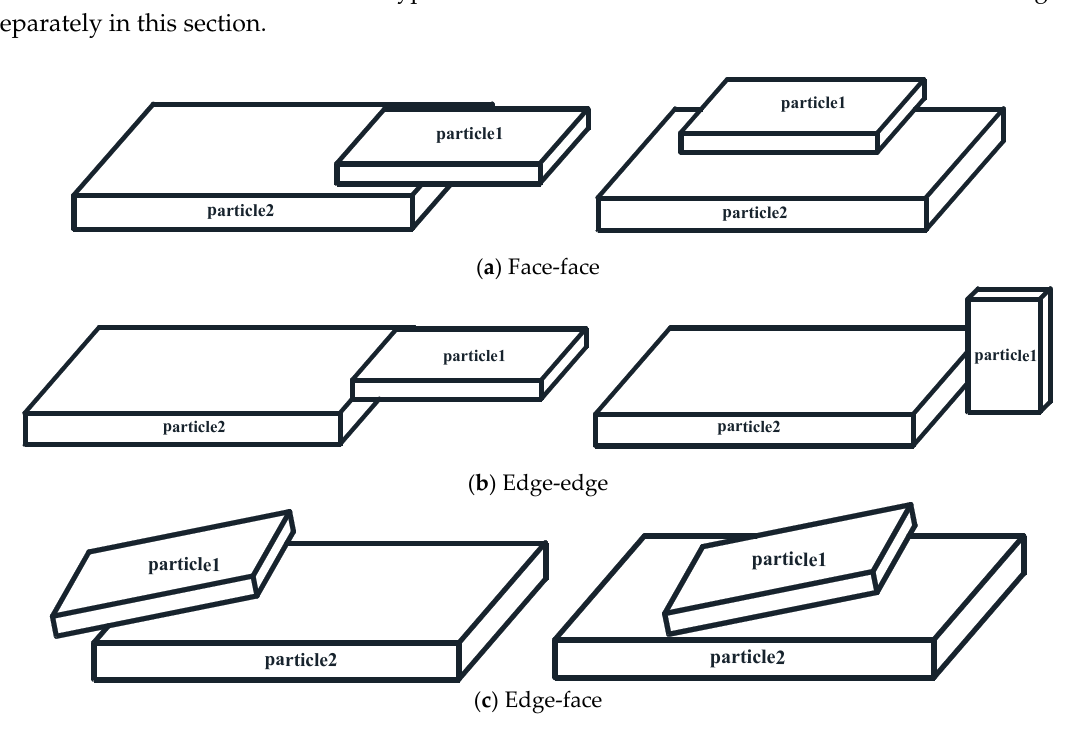
Figure 5. Schematic diagram of contact types in three-dimensional space.